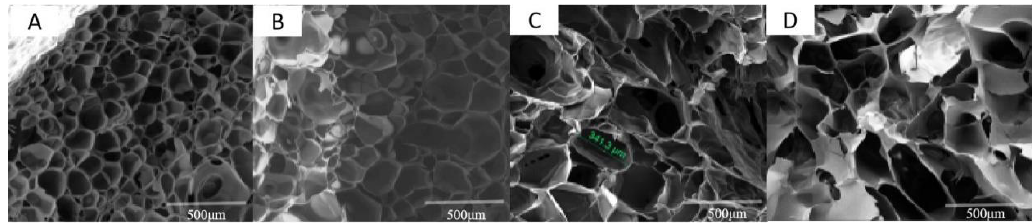
Figure 2. Scanning electron microscopy (SEM) images of AgNP–Gel / Alg sca ff olds: ( A ). Gel / Alg sca ff old (control group); ( B ). 200 µ M AgNP–Gel / Alg sca ff old; ( C ). 400 µ M AgNP–Gel / Alg sca ff old; ( D ). 600 µ M AgNP–Gel / Alg sca ff old.